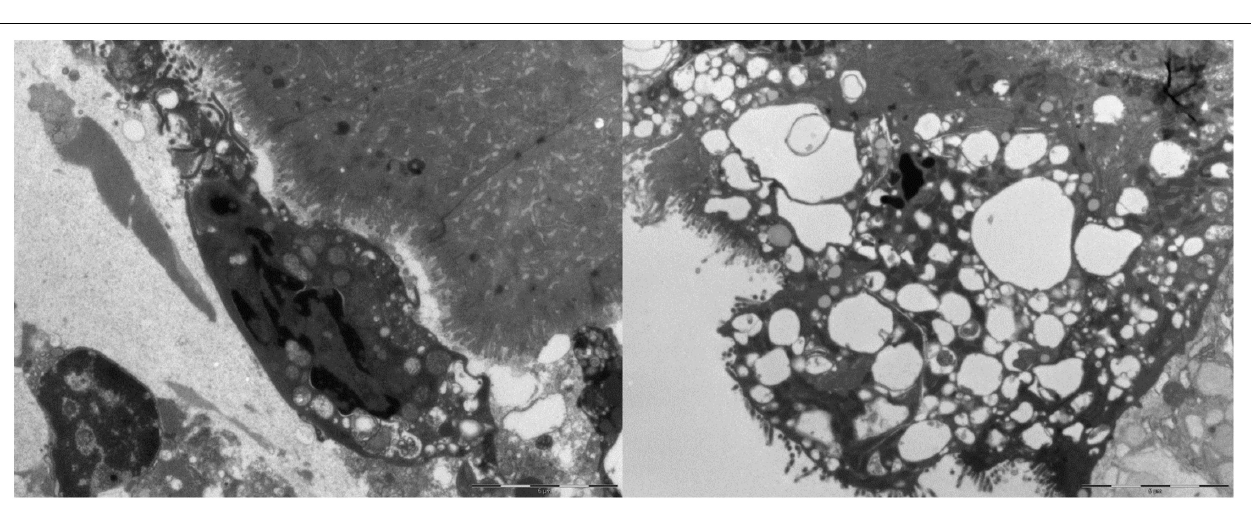
Frontiers in Nutrition |